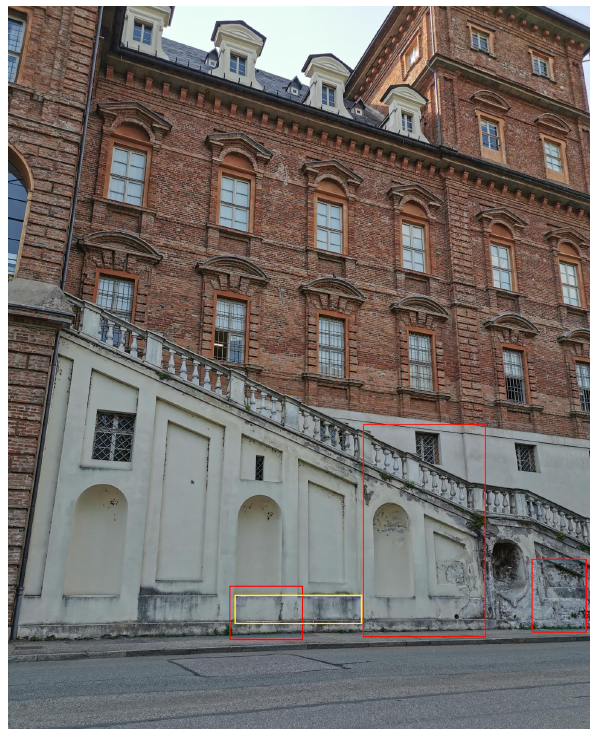
Figure 2. Castello del Valentino riverside (east) façade. The preliminary surveys are indicated with red and the detailed surveys with yellow color.